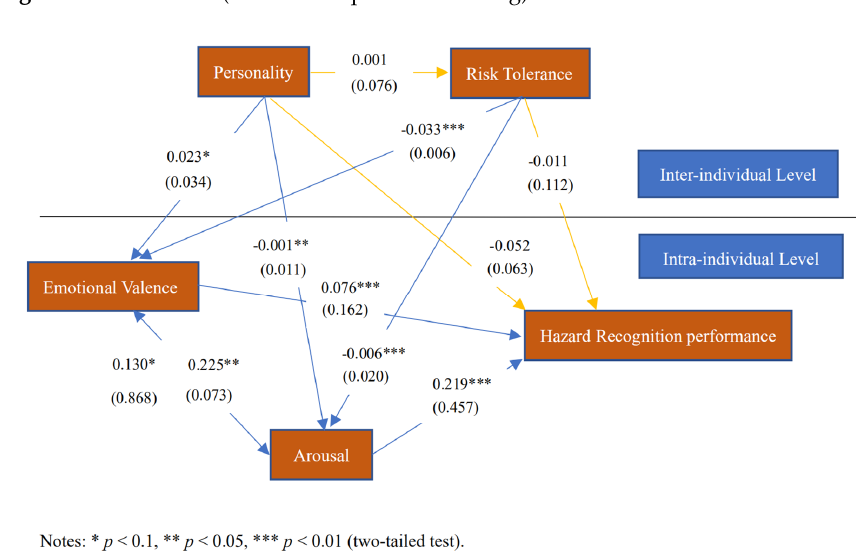
Figure 4. Initial test of the structural model, taking the hazard recognition performance as an ex- plained variable. explained